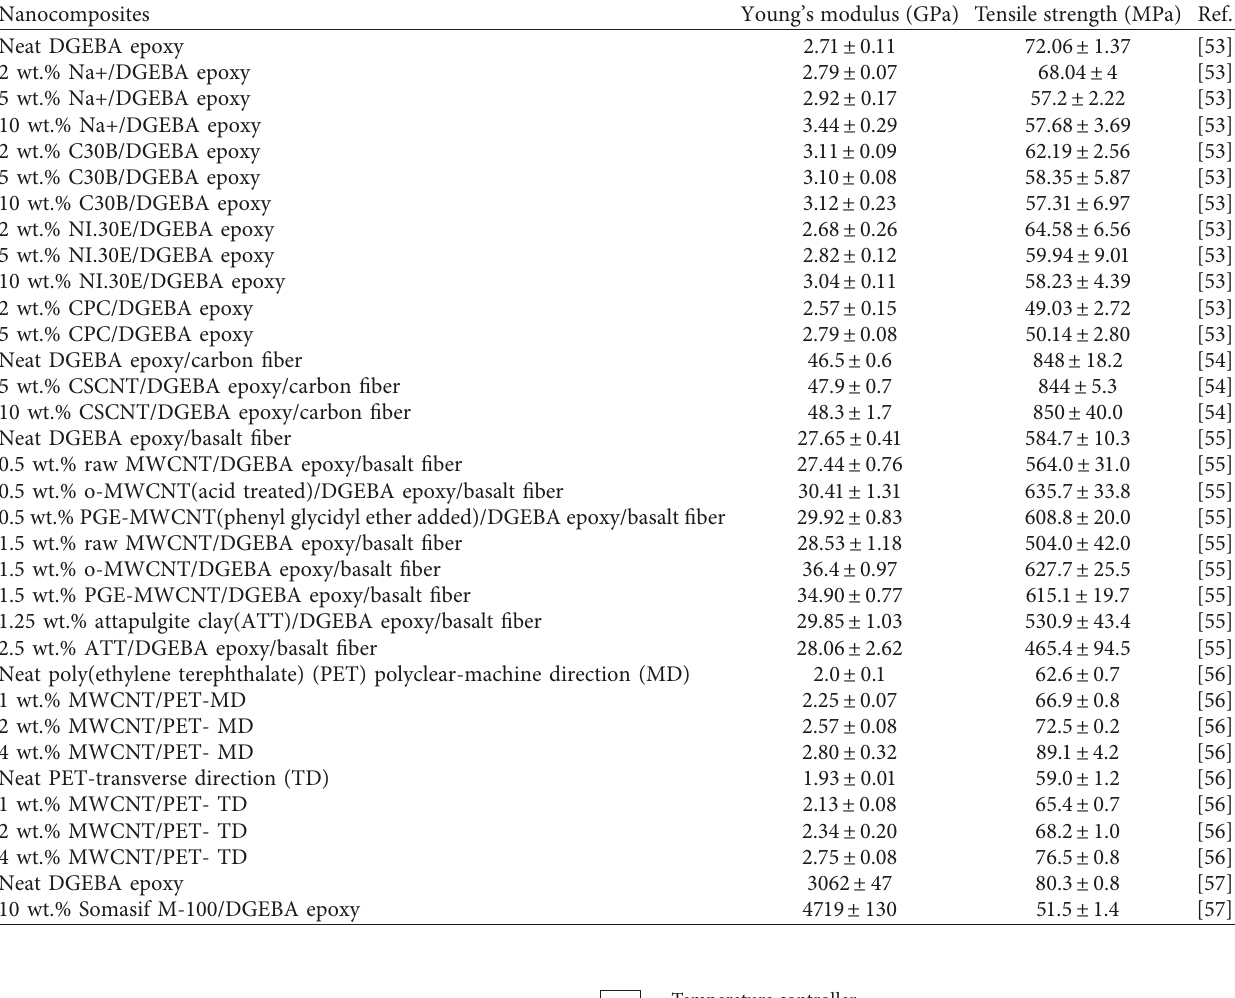
Table 1: Tensile testing results of different nanocomposites.